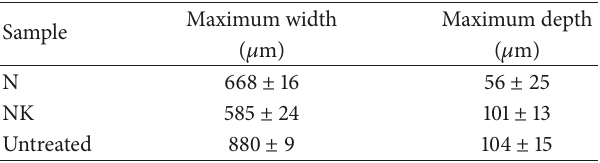
Table 8: Pit dimensions determined by